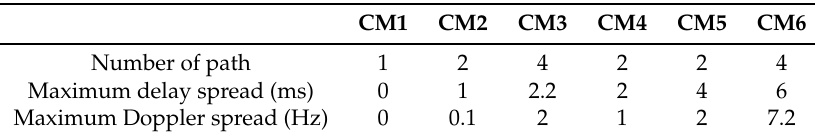
Table 2. Main parameters in DRM channel models.